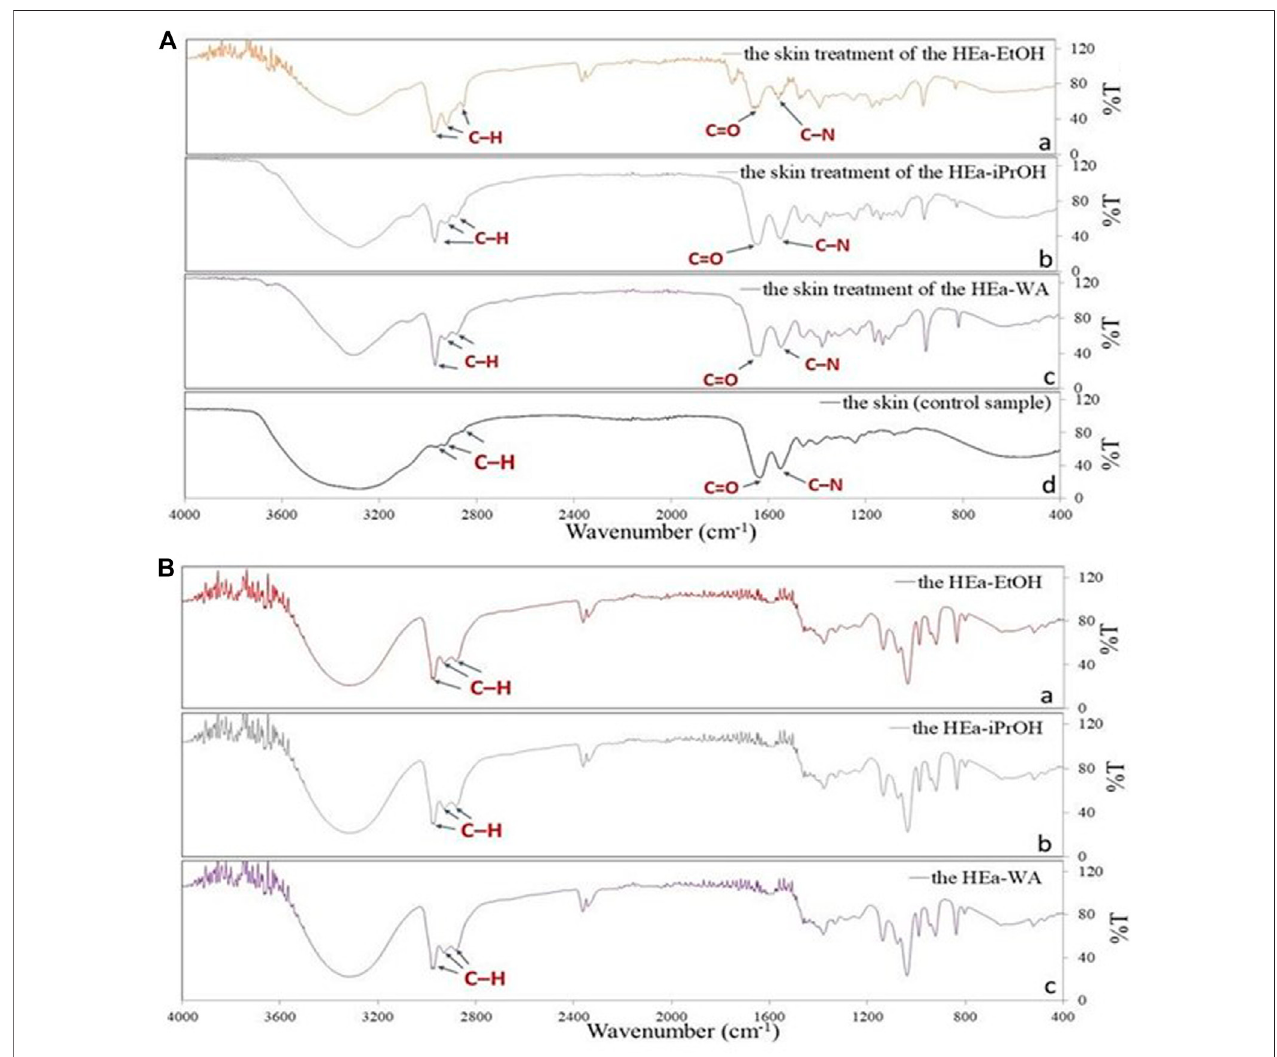
FIGURE 8 | ATR-FTIR absorption spectra of (a) pigskin treated with the hydrogel containing extract of Ea-EtOH; (b) pigskin treated with the hydrogel containing extract of Ea-iPrOH; (c) pigskin treated with the hydrogel containing extract of Ea-WA; (d) pure pigskin (control sample) (A) ; ATR-FTIR absorption spectra of (a) the hydrogel containing extract of Ea-EtOH; (b) the hydrogel containing extract of Ea-iPrOH; (c) the hydrogel containing extract of Ea-WA (B) . HEa-EtOH — hydrogel containing dry ethanolic extract of E. angustifolium ; HEa-iPrOH — hydrogel containing dry isopropanol extract of E. angustifolium ; HEa-WA — hydrogel containing dry water extract of E. angustifolium